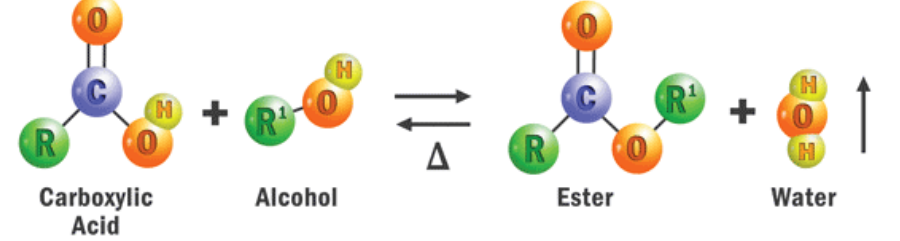
Figure 4. Reversible esterification reaction [25].